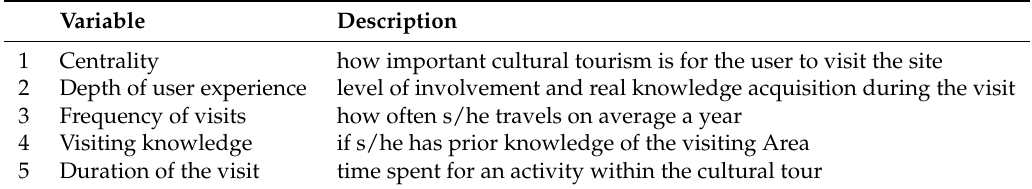
Table 2. Variables governing cultural visitor types.